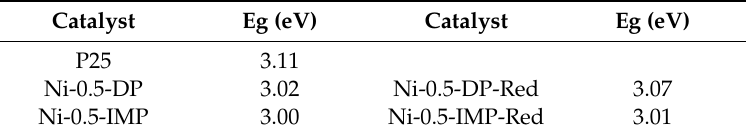
Table 2. Band-gap energy values of the solids as determined by UV-Vis